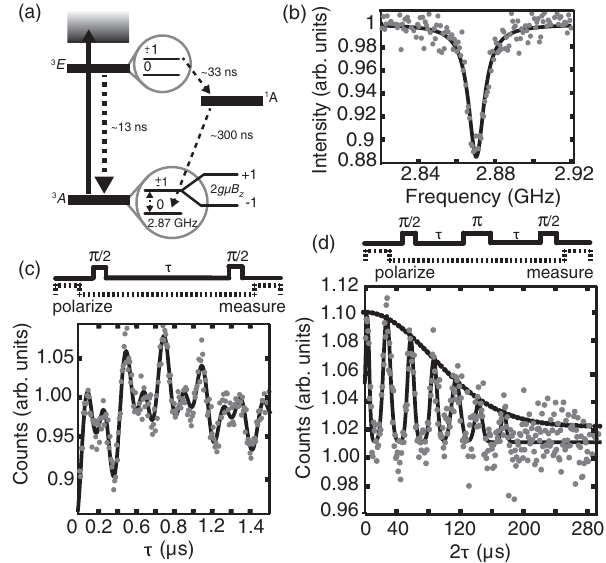
FIG. 5. (a) Level system of a NV. (b) ODMR of a NV under no magnetic field with waveguide collection. (c) The m transition is driven off resonance and three Ramsey frequencies are observed due to coupling between the NVelectronic spin and the host N 14 nuclear spin, with a decay due to the surrounding spin bath ( T (cid:3) 2 ¼ 2 μ s). (d) The π and π = 2 times of an on- resonance driving field are used to construct a Hahn-echo sequence to decouple the NV from the surrounding spin bath and measure T 2 > 120 μ s from the exponential decay of the coherent